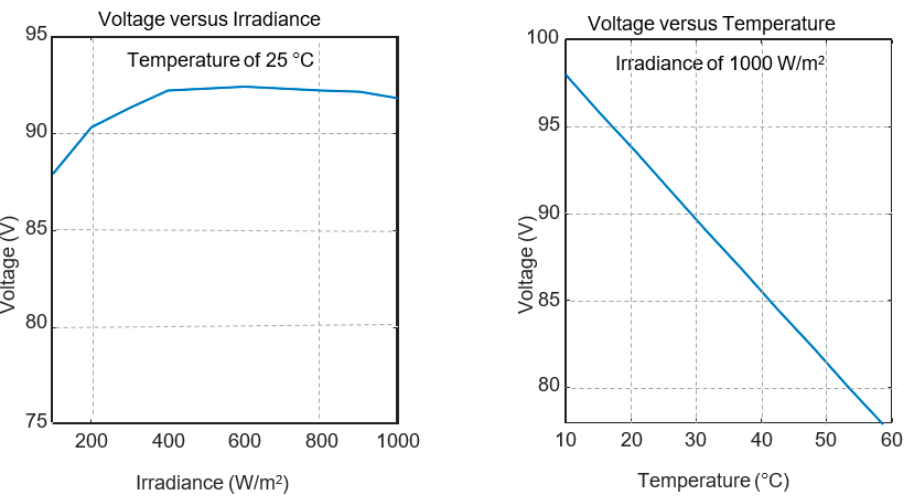
Figure 7. Characteristic curves for maximum power of photovoltaic string of 3 series modules of Isofoton ISF-250.